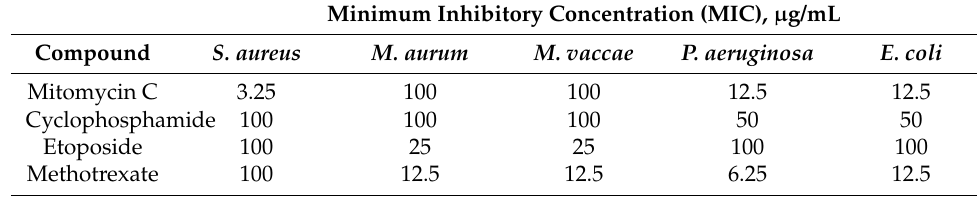
Table 1. Minimum inhibitory concentrations of antineoplastic agents against the tested bacteria. MICs were determined in three independent